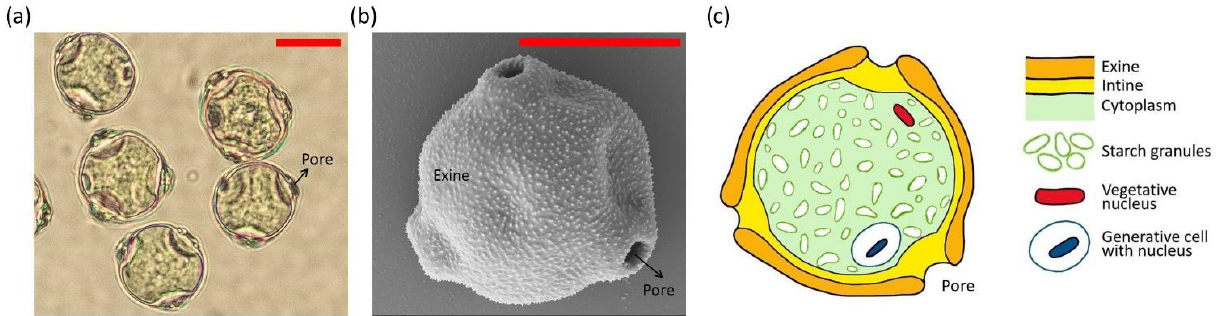
Figure 1. Different views of birch pollen grains. (a) Light microscope image of pollen grains in water. (b) Electron microscope image of a single pollen grain. (c) Schematic sectional view with the main components of a birch pollen grain. Red scale bar is